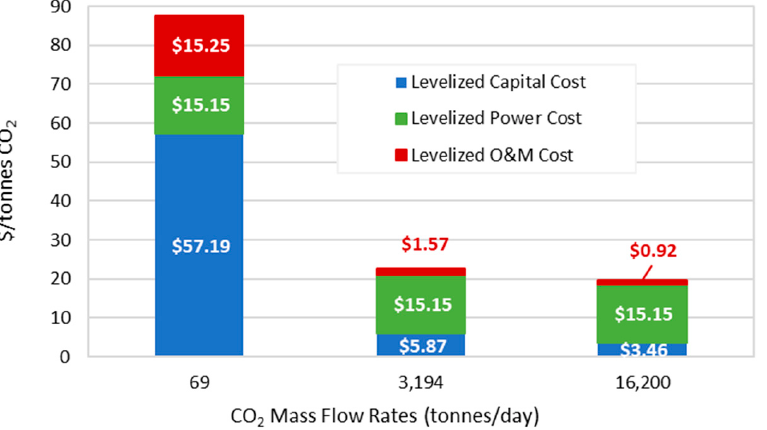
Figure 4. Contribution of capital, O&M, and power to total levelized cost of CO 2 compres- sion/pumping as a function of CO 2 mass flow rate.